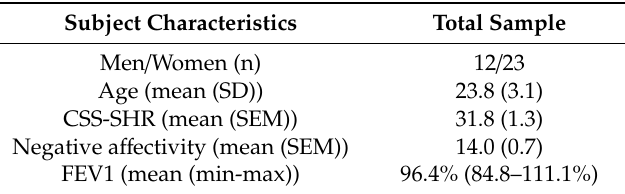
Table 1. Descriptive statistics for the total sample.